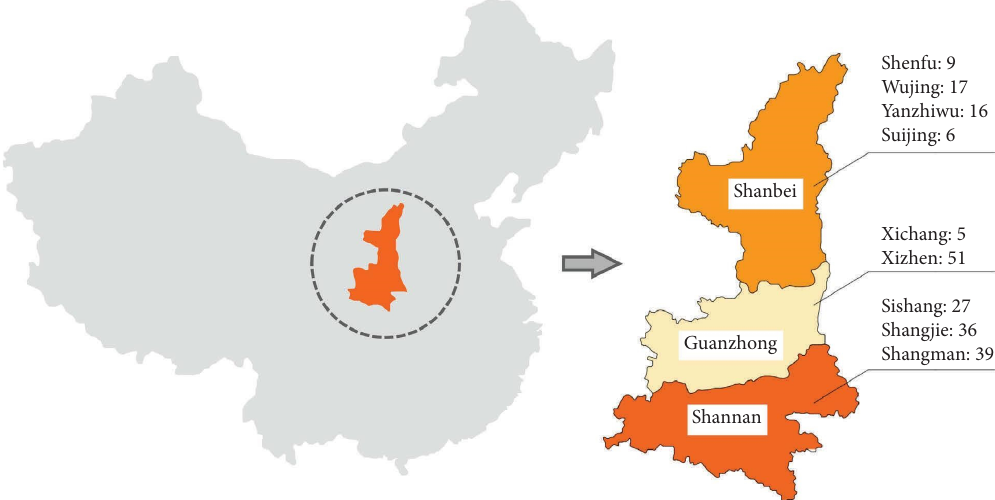
Figure 1: Distributions of highway tunnels in